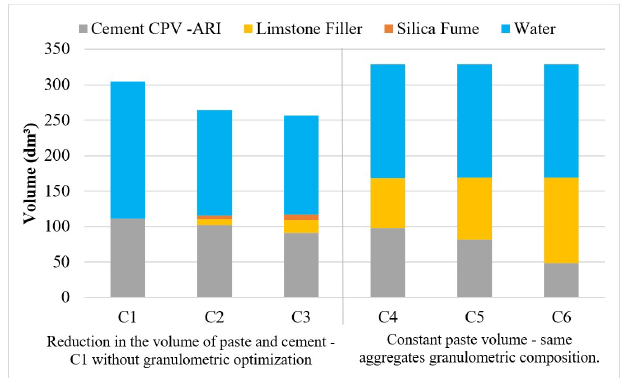
Figure 1. Volume of phases in cement